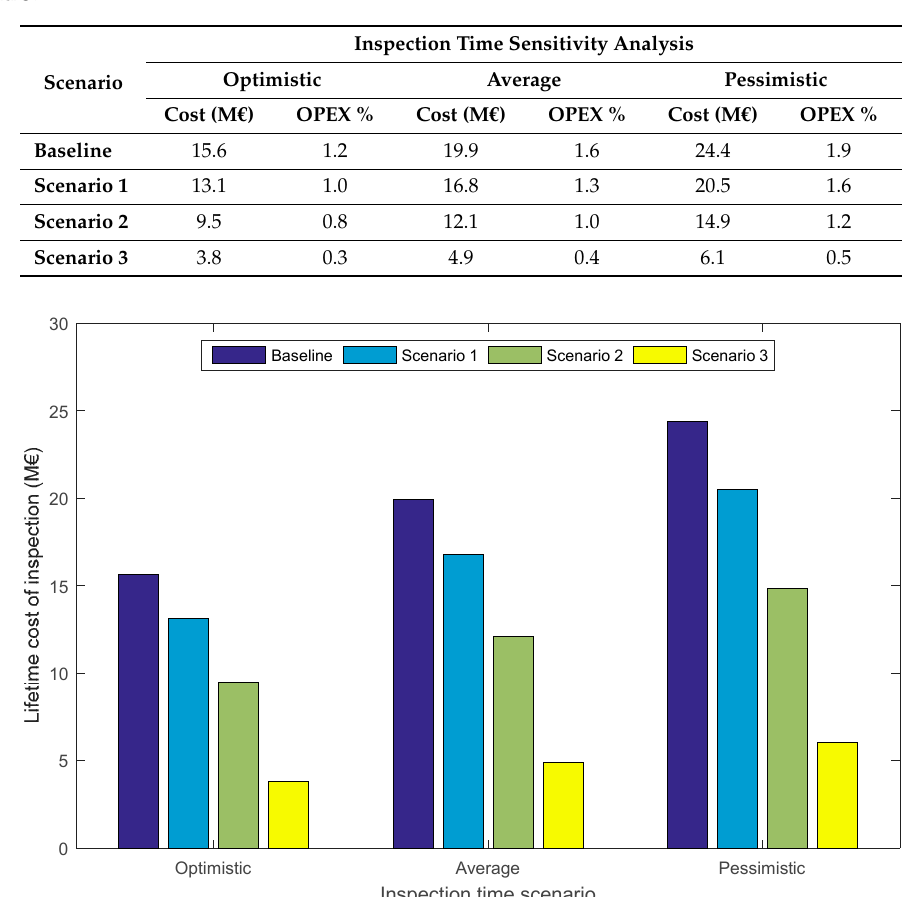
Figure 4. CAPEX increase due to SHM implementation in Scenario 3, pessimistic case of hardware costs.